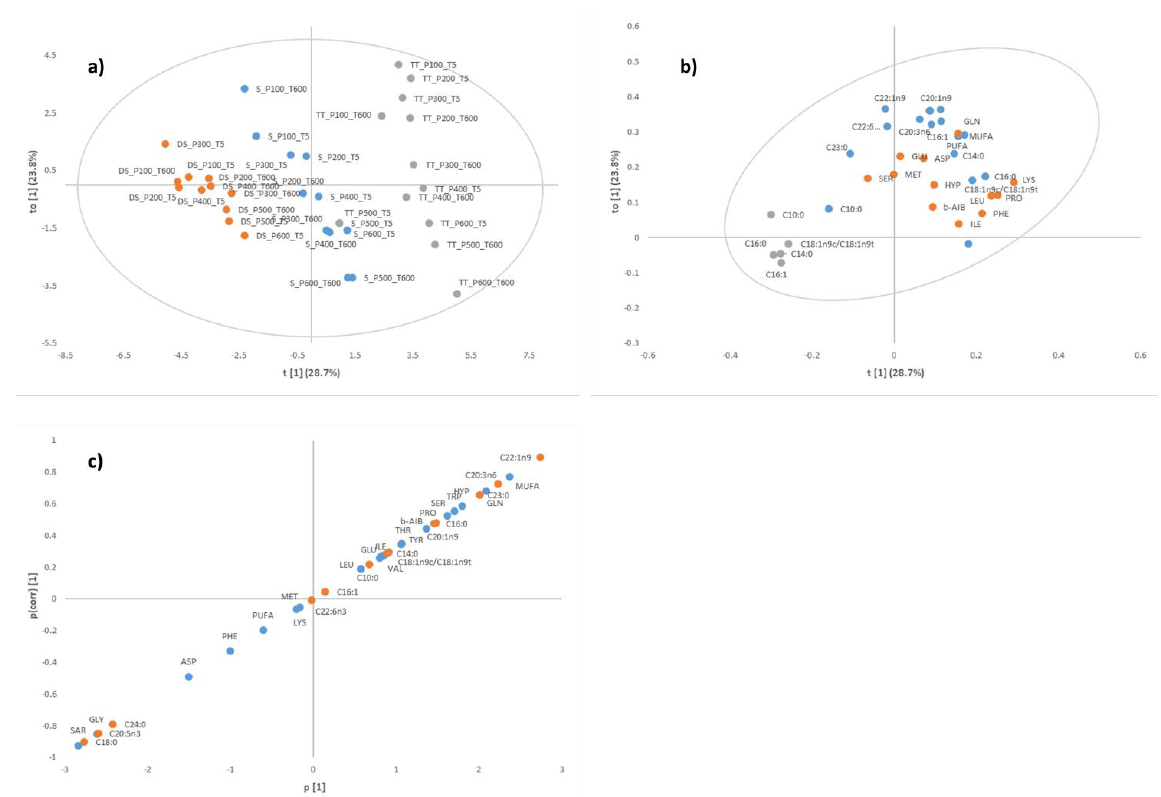
Figure 1. Orthogonal Partial Least Squares Discriminant Analysis (OPLS-DA) for all samples based on fatty acids and amino acid measures; ( a ) sample score plot (orange: Diamond Shell, blue: Storm, grey: Tua Tua), ( b ) loading plot (orange: fatty acid, blue: amino acid, grey: discriminant fatty acid and amino acid), ( c ) S-plot (orange: fatty acid, blue: amino acid). Assessed model parameters-R 2 X = 0.287, R 2 Y = 0.787 and Q 2 coefficient = 0.785.